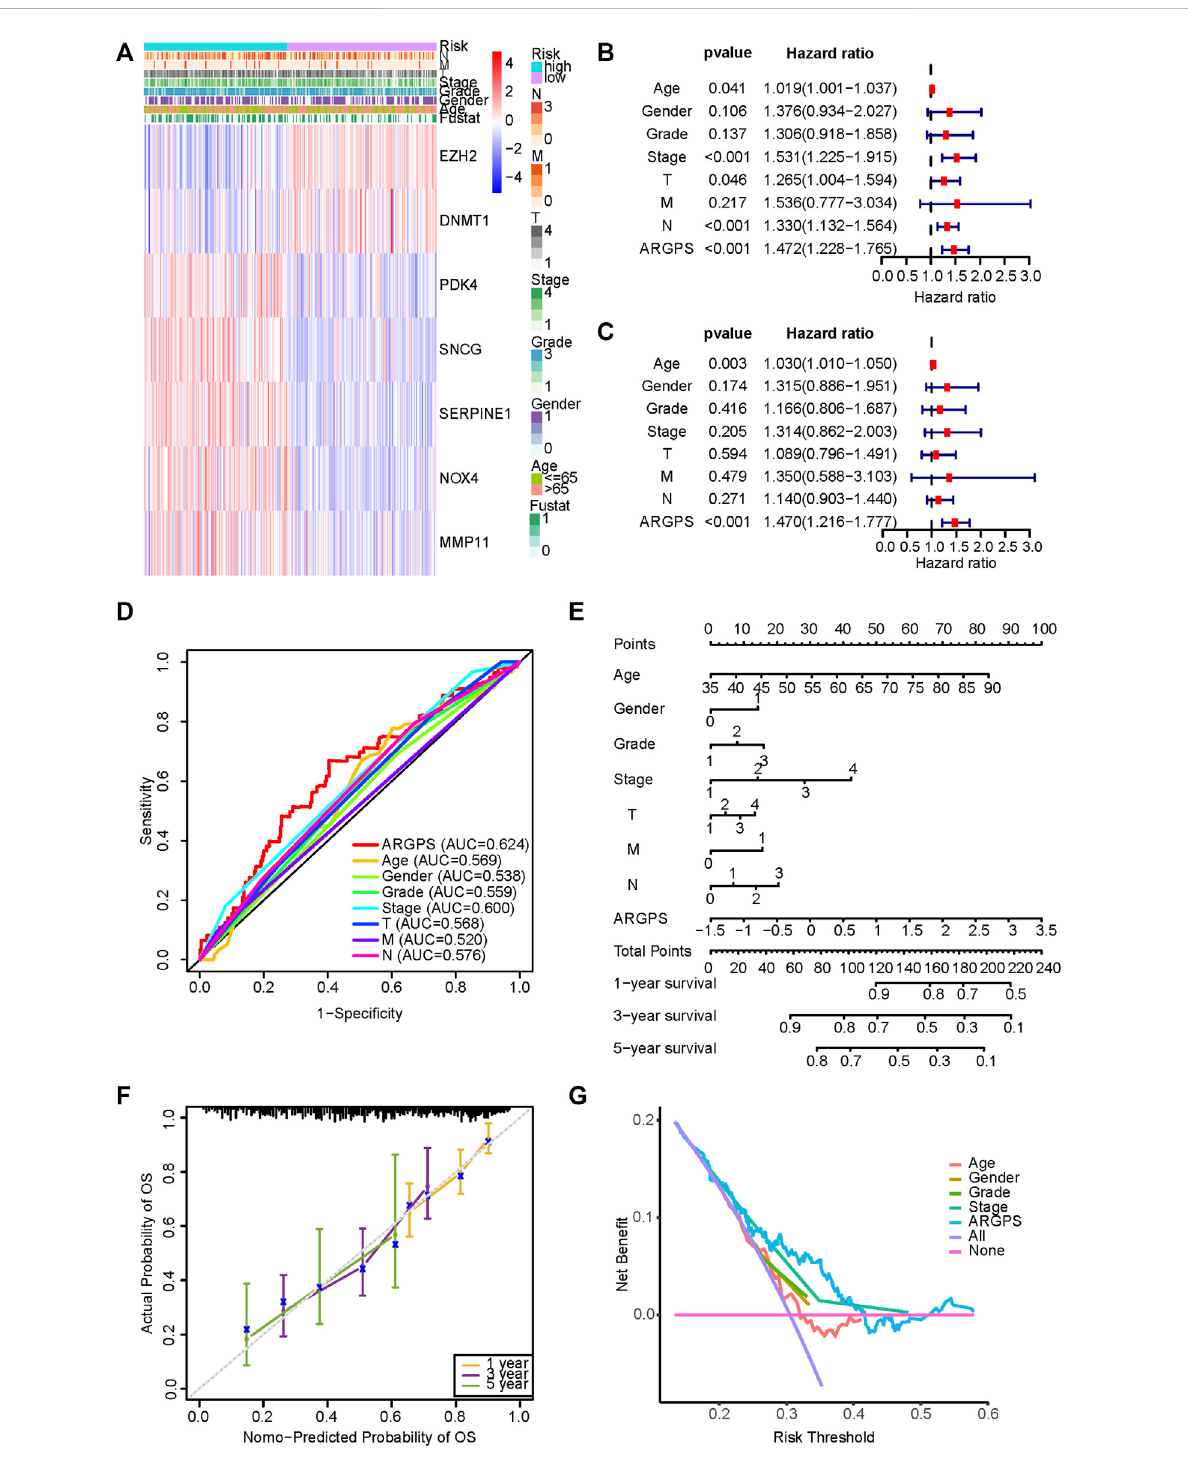
FIGURE 5 Validation of ARGPS ’ s ability to predict the prognosis of gastric cancer. (A) The differences in the expression of seven markers and the distribution of clinicopathological features between the two risk groups in the TCGA cohort were plotted by the heat map. The results of univariable (B) and multivariable Cox regression analysis (C) between ARGPS and clinicopathological factors. (D) The ROC curves based on the ARGPS model andotherclinicopathological factorsintheTCGAcohort. (E) NomogrambasedonARGPSandclinicopathological featuresintheTCGAcohort. (F) Calibrationcurvesforthevalidationofthenomogram. (G) DCAcurvesoftheclinicalutilitybetweenARGPSandotherclinicalfactorsregardingthe overall survival (OS) in the TCGA cohort. TCGA, The Cancer Genome Atlas; ARGPS, anoikis-related gene prognostic score; ROC, receiver operating characteristic; DCA, Decision curve